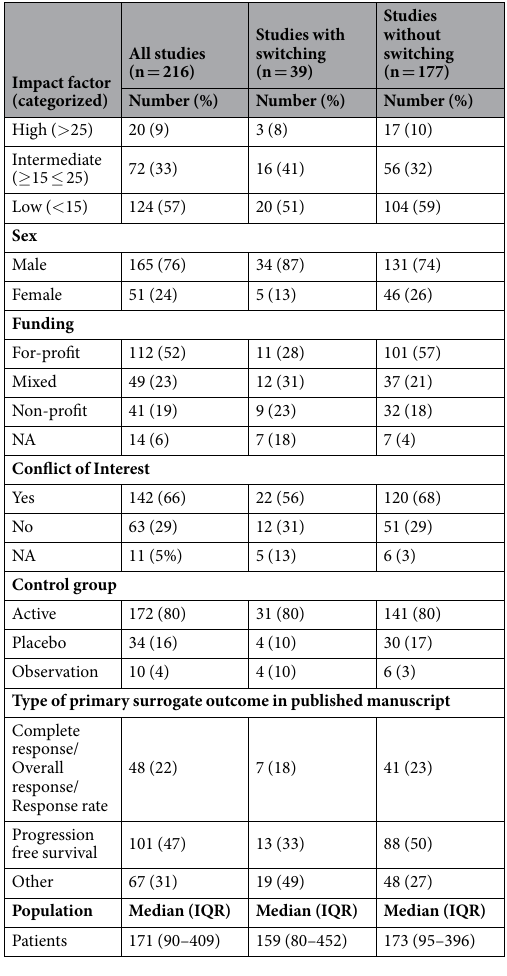
Table 2. Characteristics of included